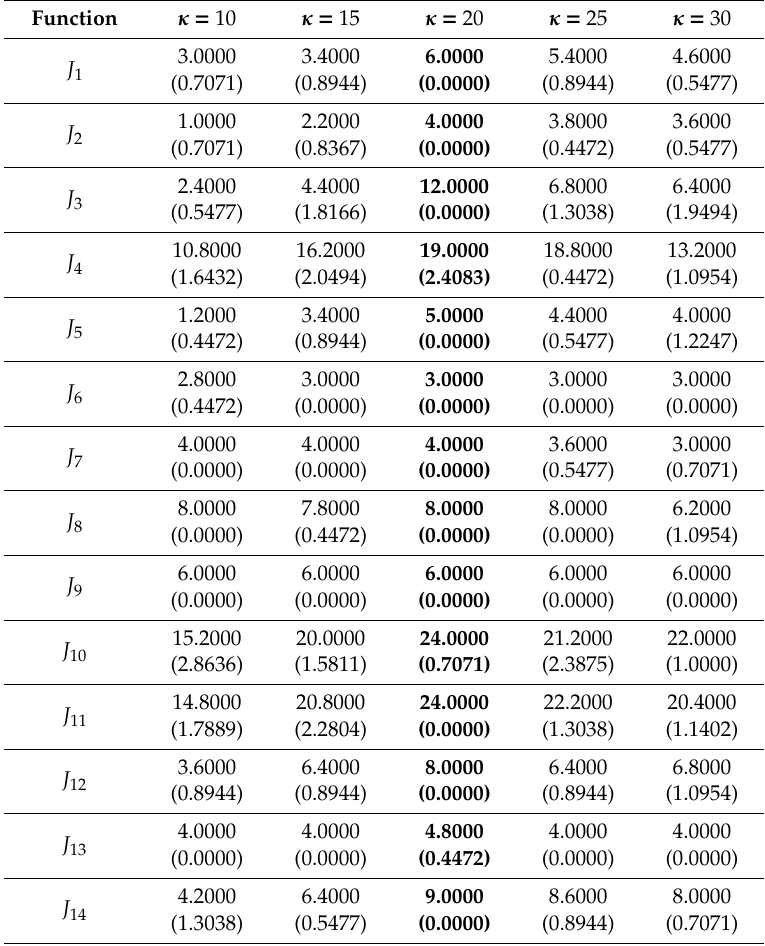
Table 2. Sensitivity analysis of the κ